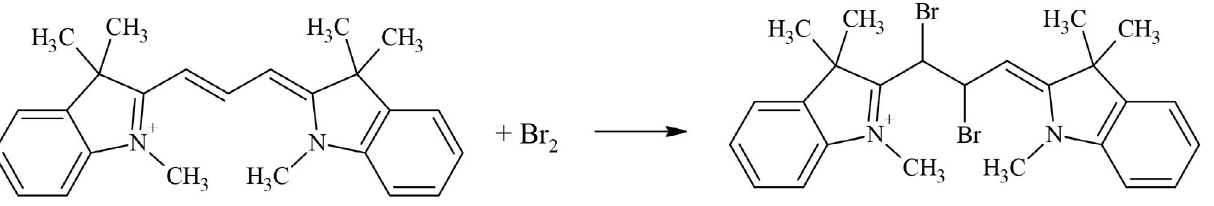
Fig. 1 . A probable scheme of astrafloxine FF interaction with bromine in aqueous